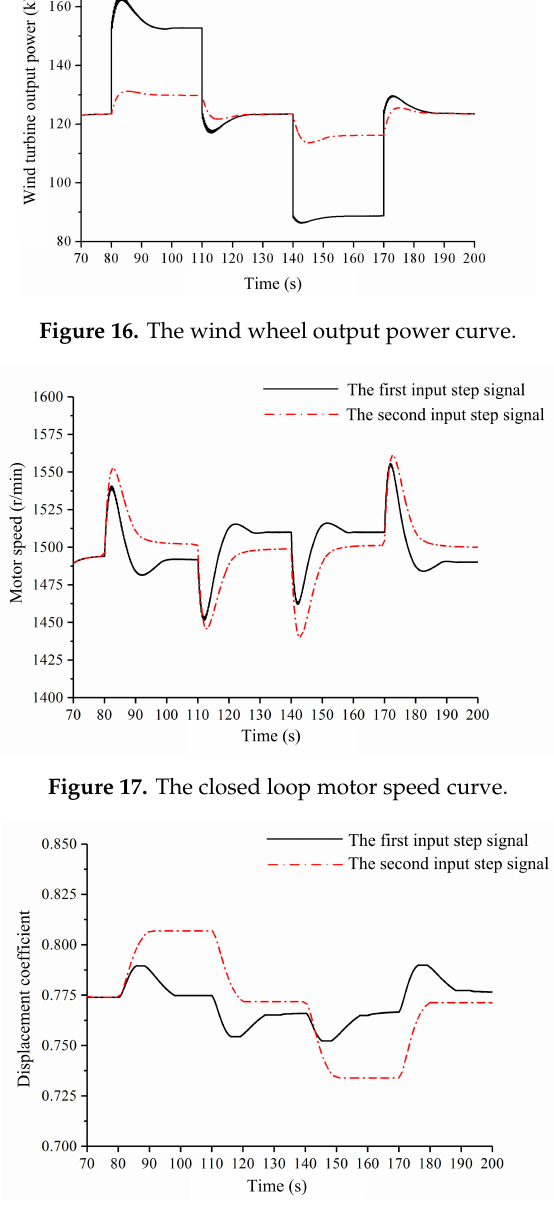
Figure 16. The wind wheel output power curve.